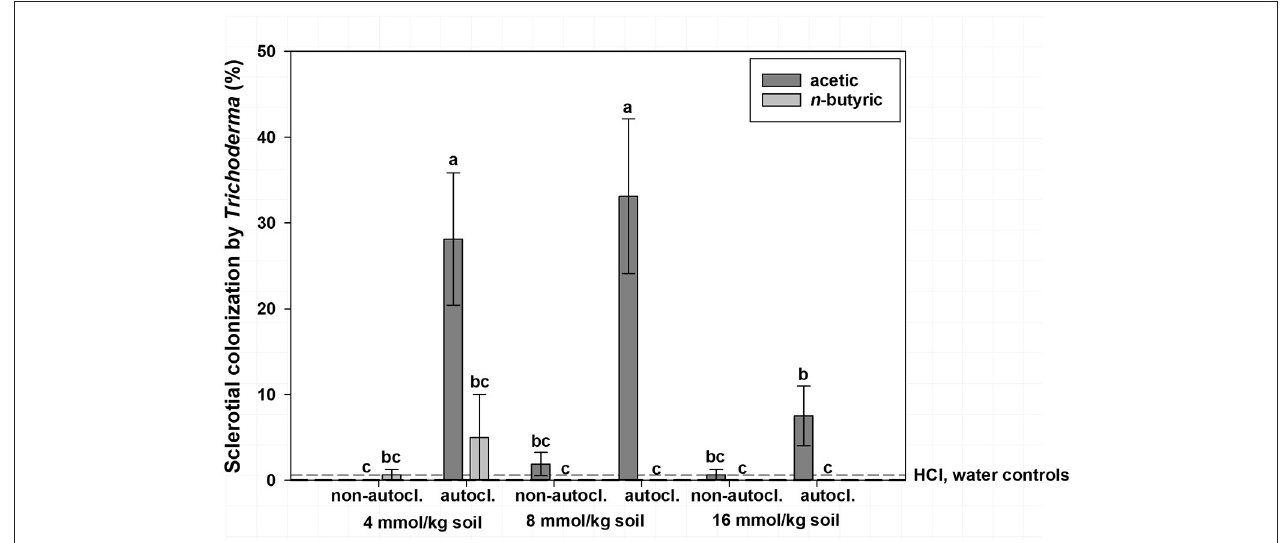
FIGURE 3 | Mean percentage colonization of A. rolfsii sclerotia by Trichoderma spp. in experiment 1 as affected by volatile fatty acid (VFA), VFA concentration and soil autoclaving. Bars indicated by the same letter are not significantly different according to an F-protected LSD at P ≤ 0.05. Error bars represent standard error of the mean.